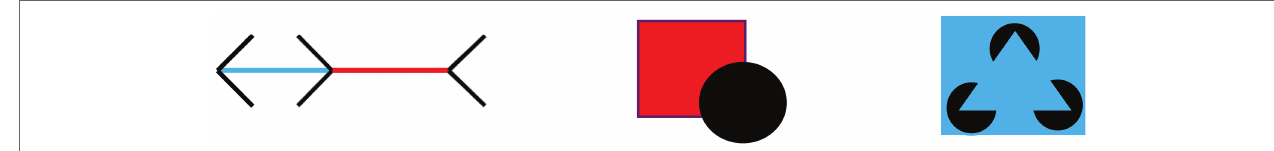
FIGURE 1 | Left to right: Brentano version of ML illusion, occluded figure, Kanizsa